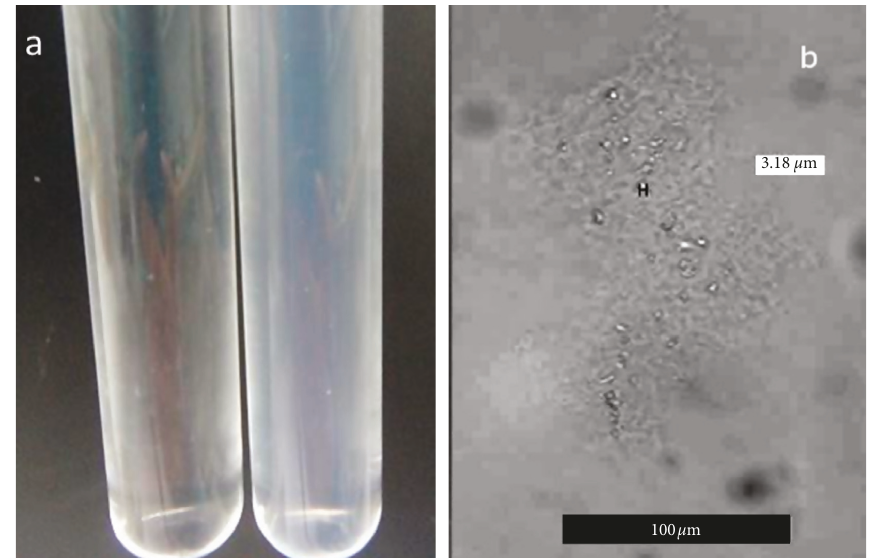
Figure 1: Hydrogels obtained by adding (a) CS onto CMC and (b) CMC onto CS at a ratio of 75/1 (pore size around 3 µ m).